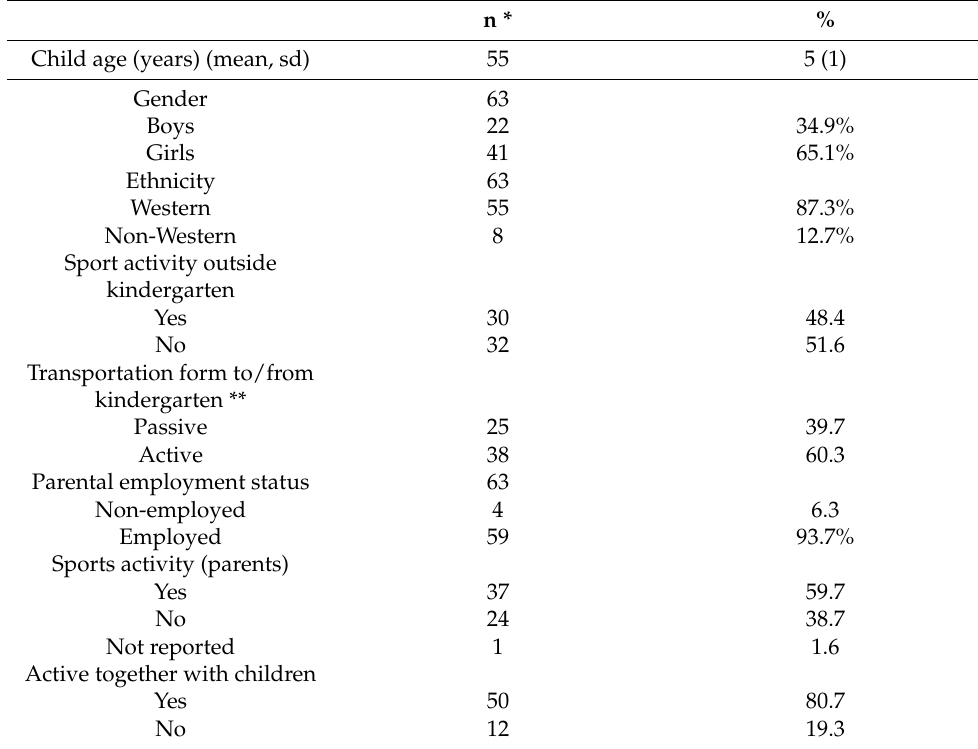
Table 1. Characteristics of the included participants. Results presented as percentages unless otherwise stated. n * % Child age (years) (mean, sd) 55 5 (1) Gender